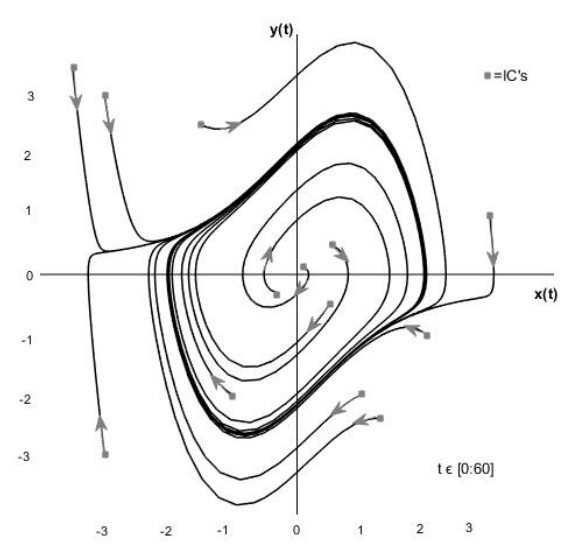
Figure 1. Phase plane diagram for the van der Pol equation with µ = 1.0 (and without forcing term) exhibiting a limit cycle, v = dx/dt . Reproduced from [13], Published by IOP Publishing 2017.